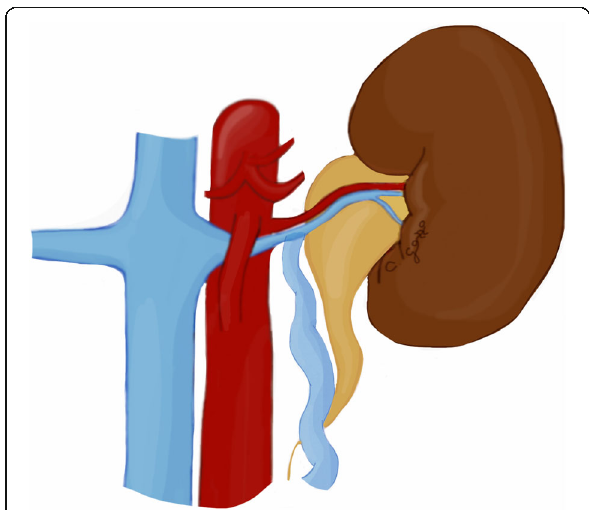
Fig. 15 Drawing illustrating the coronal view of left ovarian vein syndrome